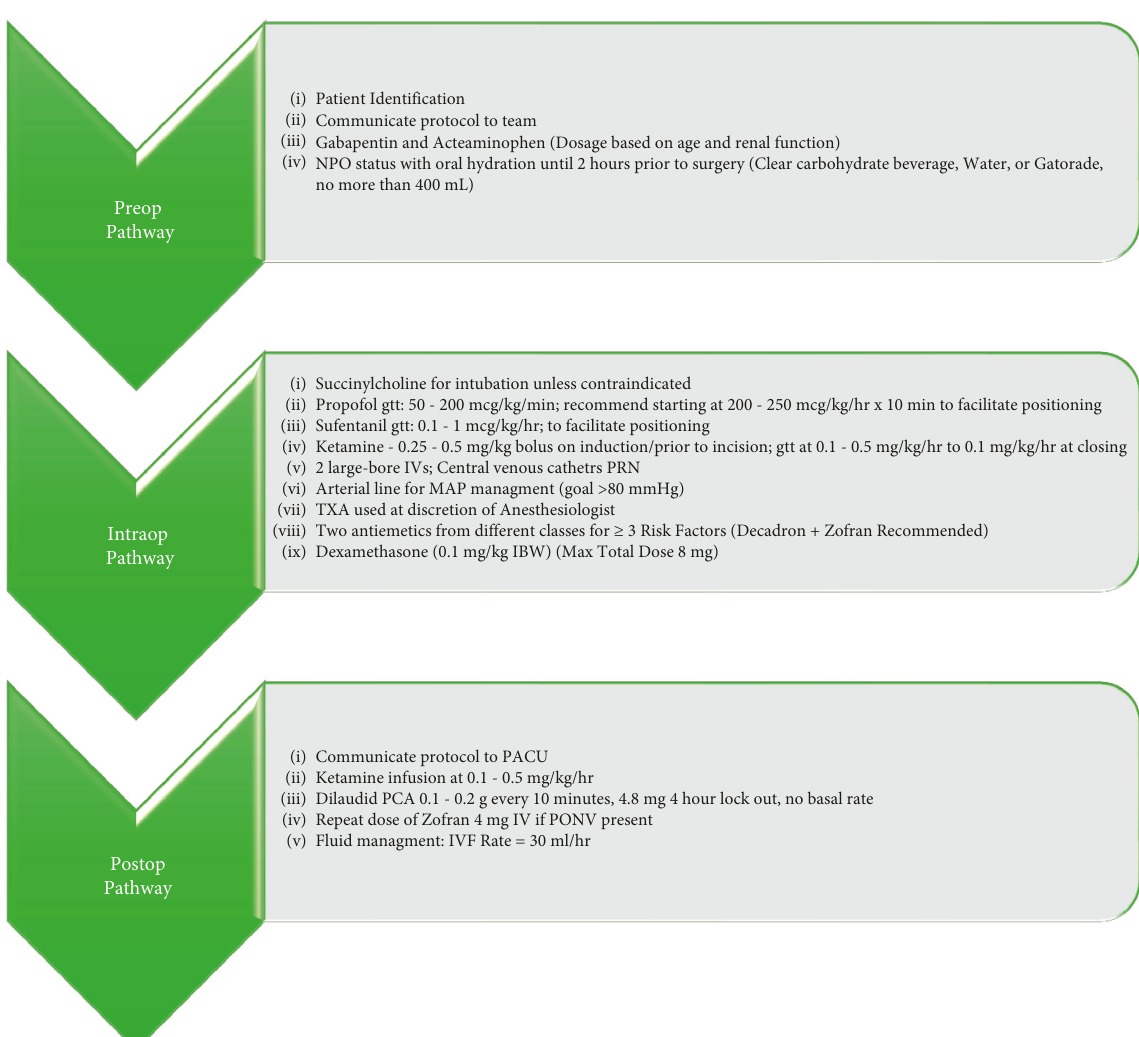
Figure 1: Proposed analgesic algorithm to limit opioid consumption in spine